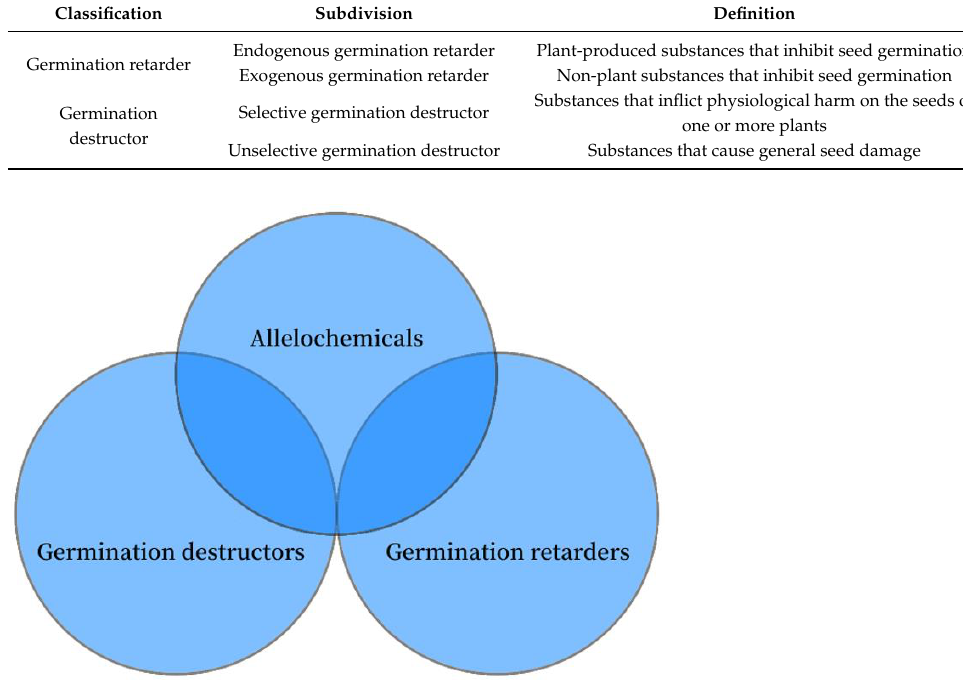
Table 2. Classification of germination inhibitors by chemical structure. Name of Germination Inhibitors